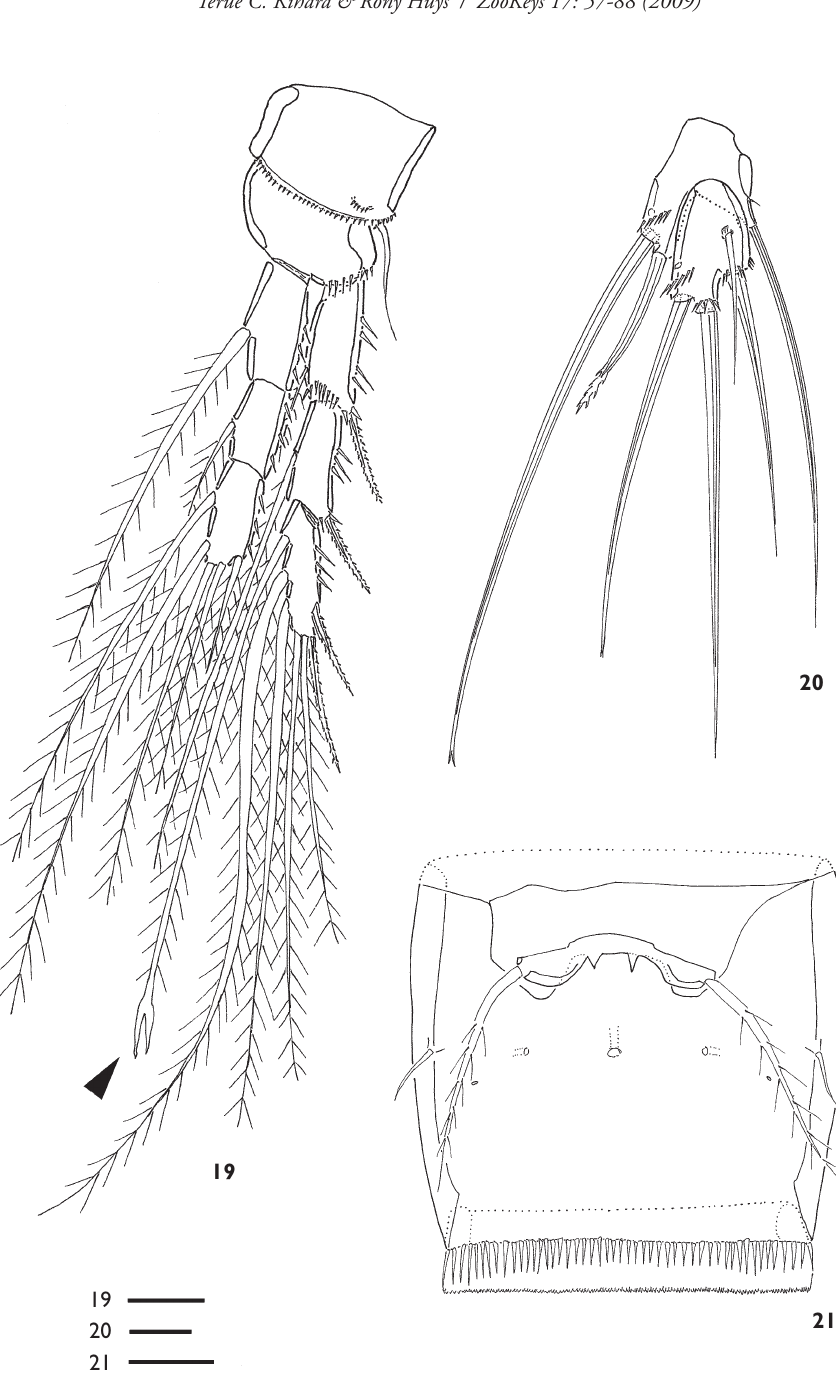
Figures 19-21. Chaulionyx paivacarvalhoi gen. et sp. n. ♀ : 19 P4, anterior [seta with bifi d apex arrowed] 20 P5, anterior 21 genital double-somite. Scale bars = 10